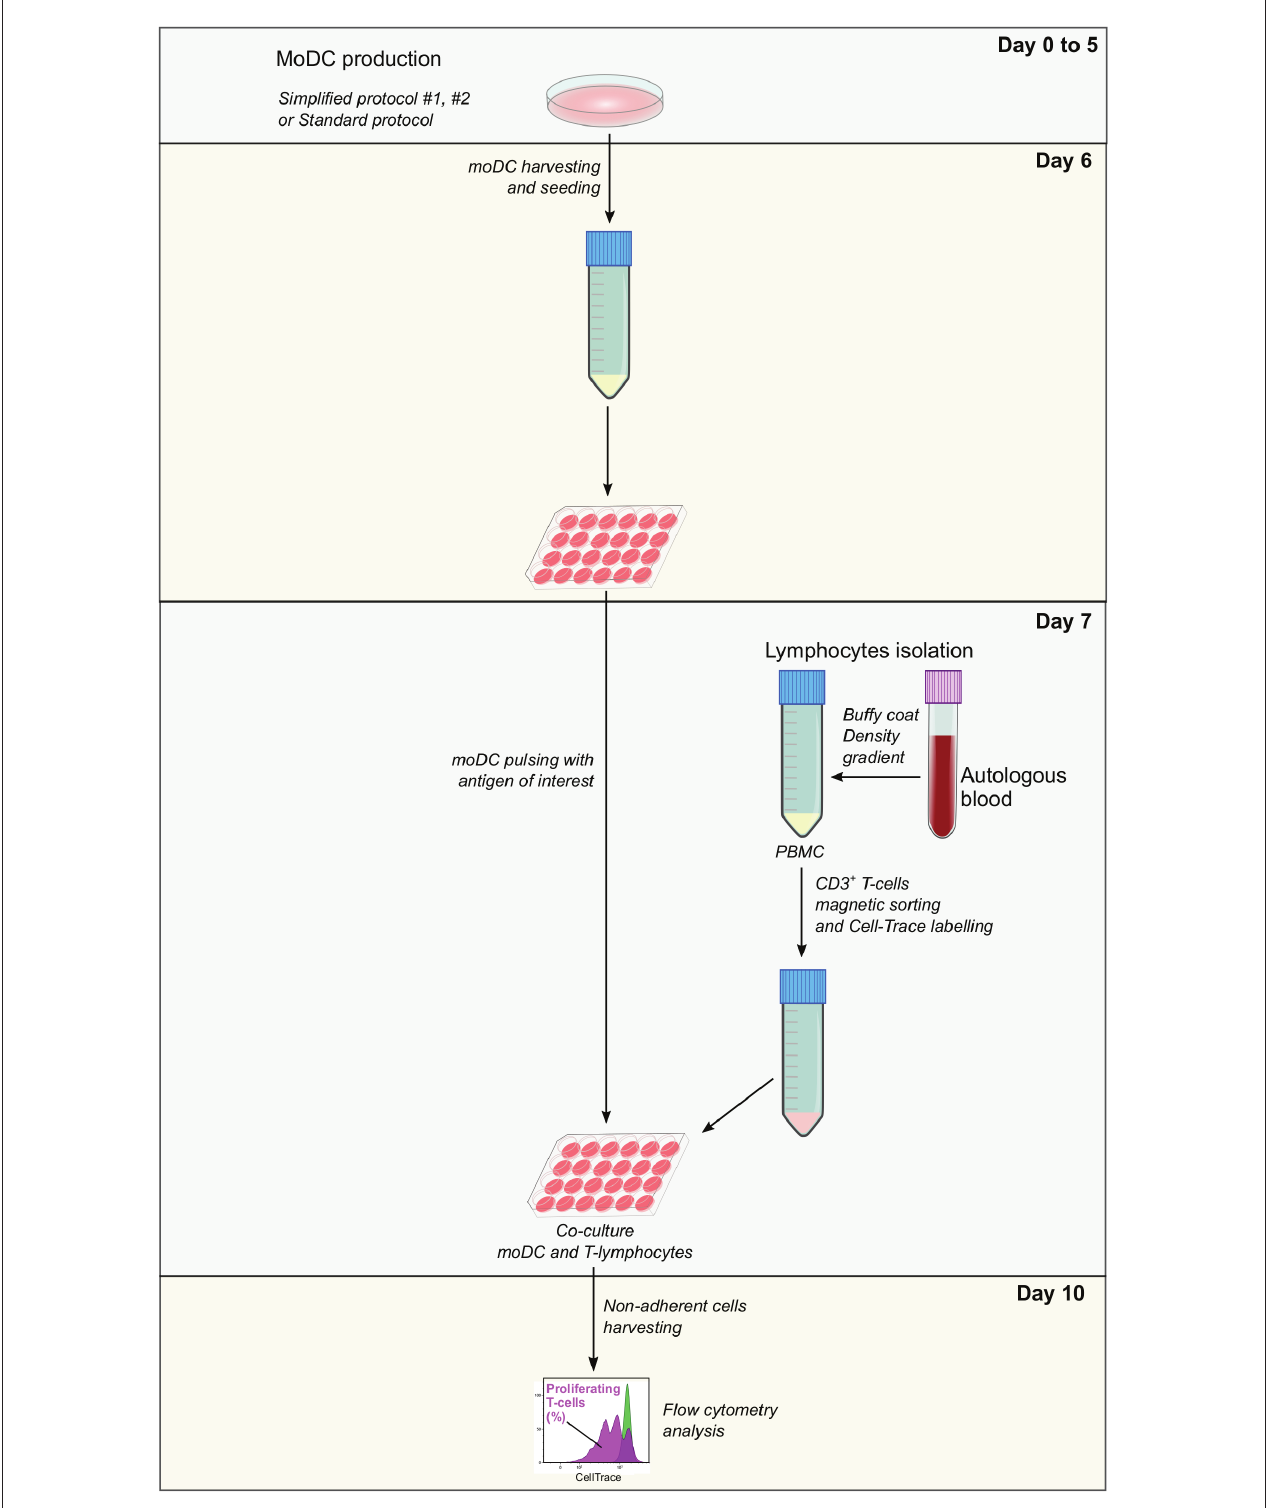
FIGURE 2 | Antigen presentation assay. Monocyte-derived dendritic cells produced using simplified or standard protocols are harvested and pulsed with the antigen of interest at day 6. In parallel, autologous PBMC isolated from EDTA-treated blood samples are used to obtain CD3 + T cells by magnetic sorting. T cells are labeled with CellTrace Violet, co-cultured with pulsed moDC and after 3 days, non-adherent cells are collected and analyzed by flow cytometry. The levels of antigen presentation are estimated based on the percentage of proliferating T cells.